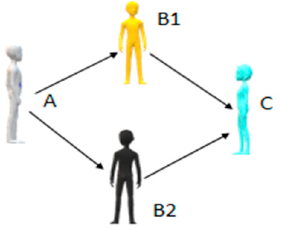
Figure 1. Trust network graph.